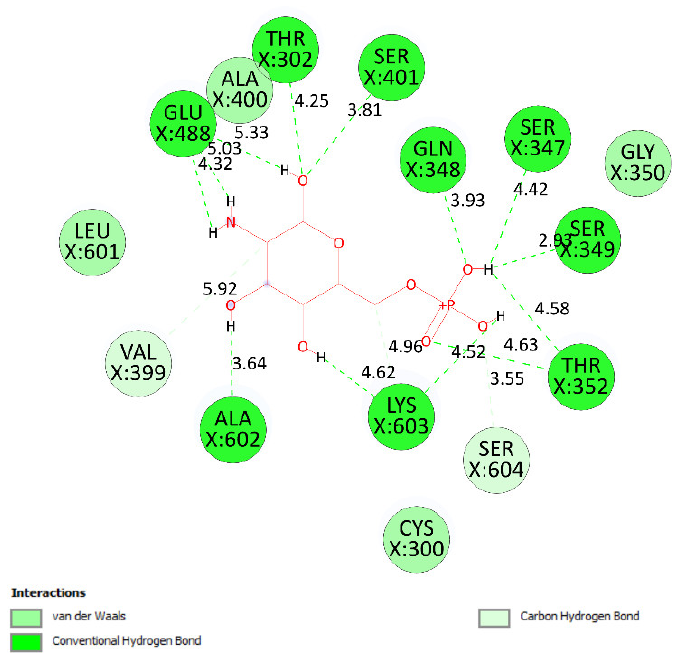
Figure 26. Diagram detailing the significant ligand interactions forming from pose 83, one small ligand, to active atoms on enzyme 2VF5.